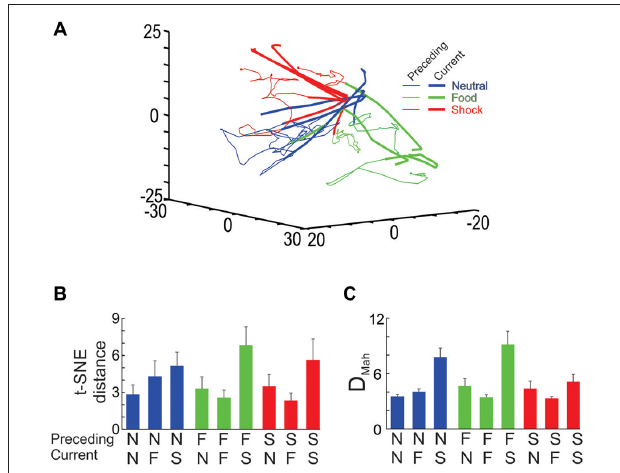
FIGURE 9 | Ensemble transitions during the interleaved trial sessions. (A) The full dimensional MSUA space was reduced to 3 dimensions using t-SNE. Nine types of trials were identified and plotted separately. In each case, the time bin associated with the end of the outcome period of the preceding trial was denoted by a dot and the distance in MSUA space from this point, through the ITI and into tone period on the subsequent trial was plotted as a vector in the space. The tone/outcome period of the current trial was denoted by the thickening of the line vector. The dots and thin lines were colored based on the type of outcome on the preceding trial (food outcome = green, shock outcome = red, null outcome = blue), whereas the thickened line segments were colored based on the type of tone/outcome on the current trial (F-block = green, the N-block = blue, S-block = red). (B) The MSUA space was reduced to one dimension using t-SNE and the distance traversed by each of the nine vectors shown in (A) were calculated. The bars were colored as in (A) based on the preceding trial (N = neutral trial, F = food trial, S = shock trial). (C) The D Mah between the last 5 s of the preceding trial and the 5 s tone period of the current trial were calculated for the same nine trial types and plotted in the same way. In both (B,C) the calculations were performed on each session separately and the averages (and SEM) are